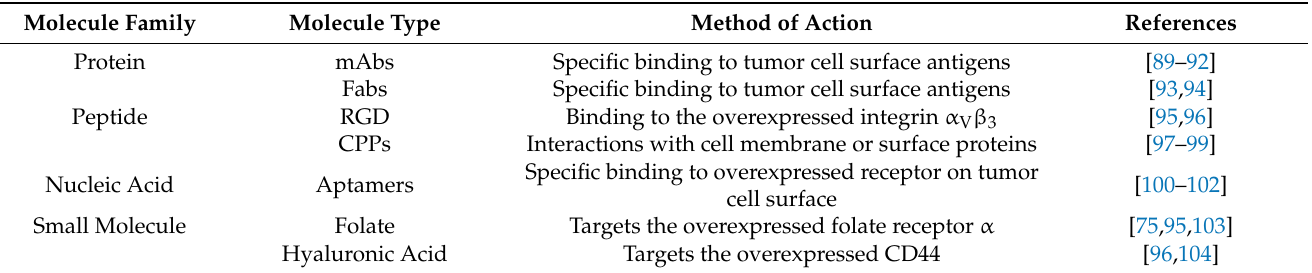
Table 2. Targeting modality for